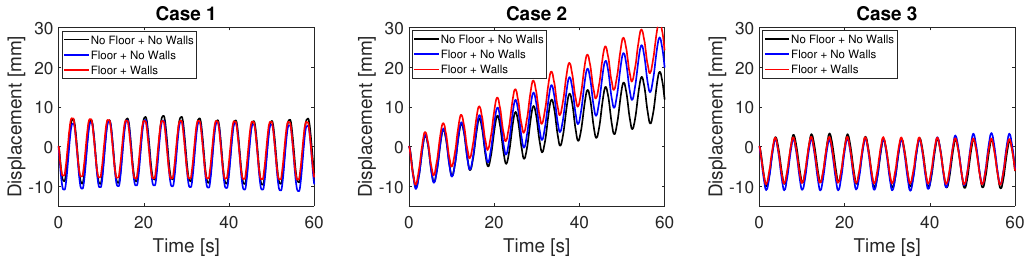
Figure 5. Displacement of the robot in the three cases when it is far away from the floor ( h = 160 mm), near the floor ( h = 5 mm), and near the floor and wall ( h = 5 mm and w = 5